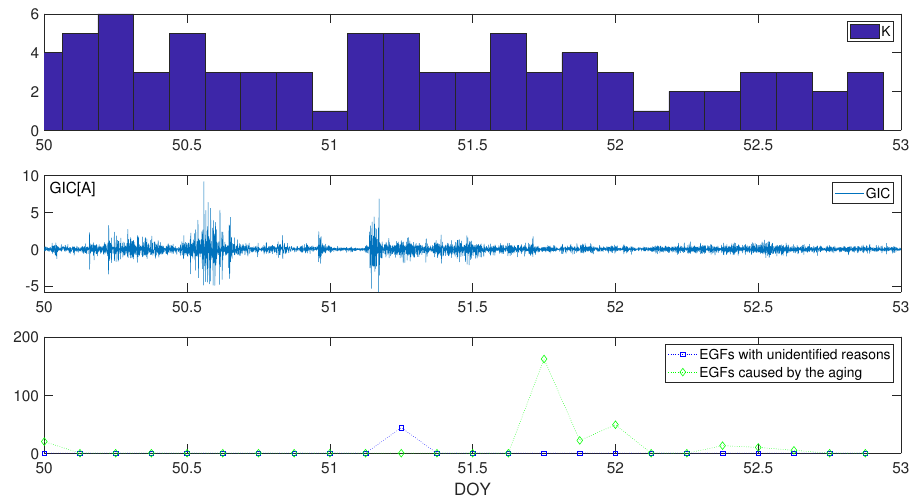
Figure 4. K index from Belsk (3-h resolution), computed geomagnetically induced currents (1-min resolution) and electrical grids failures (EGFs) (3-h resolution) around 19 February 2014 (50 doy). On the horizontal axis is marked the